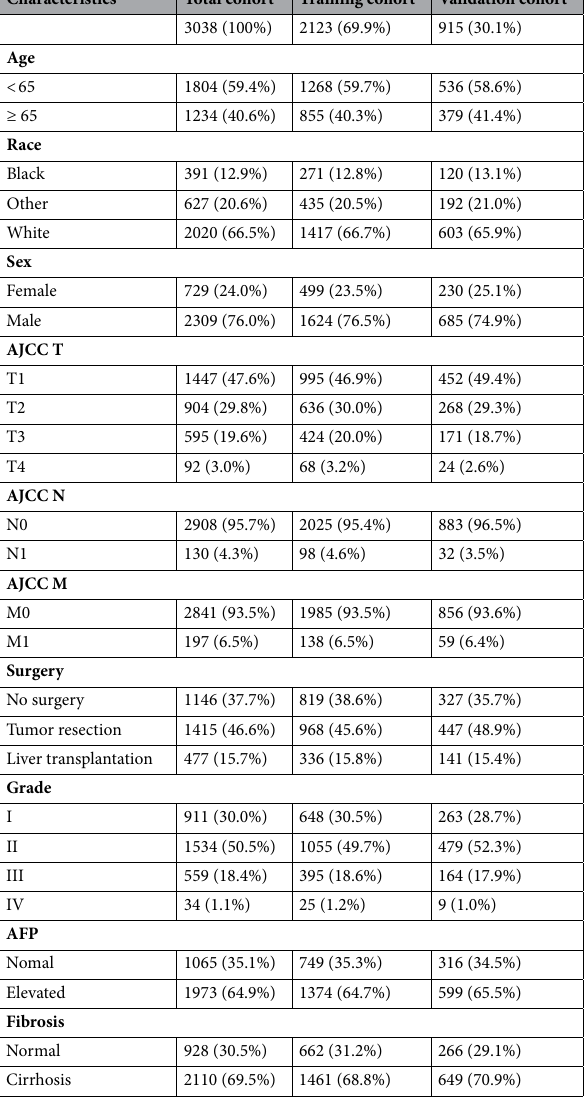
Table 1. HCC patient characteristics in the